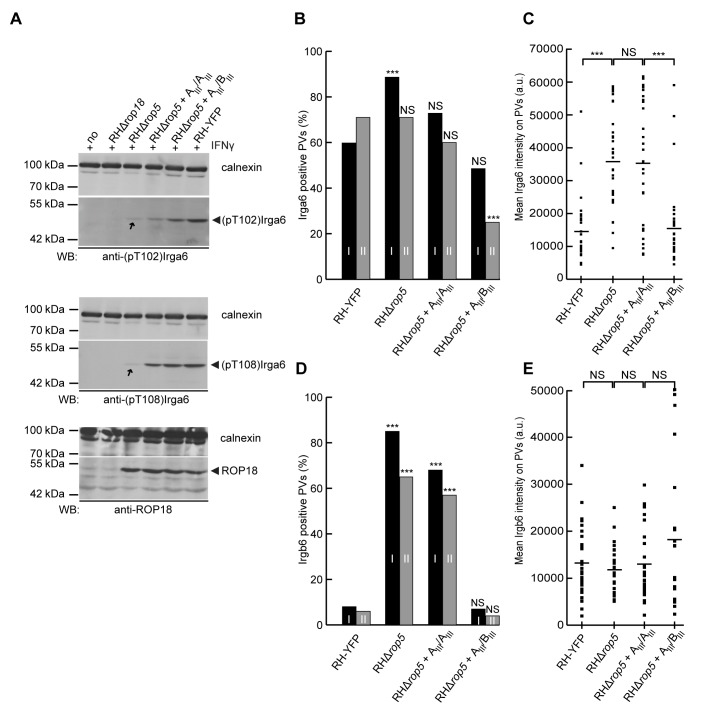
ROP5 isoforms restore virulence-associated functions to RHΔrop5.(A) IFNγ-stimulated L929 cells were left uninfected (no) or infected for 2 h with either of the two deletion strains, RHΔrop18, RHΔrop5, or the RHΔrop5 strain transgenic for ROP5 isoforms RHΔrop5+AIII/AIII, or RHΔrop5+AIII/BIII (see Materials and Methods for further details) or RH-YFP. Lysates were resolved on SDS-PAGE and stained on Western blots with anti-pT102 (upper panel) and anti-pT108 (middle panel) antibodies. Expression of ROP5 isoform AIII in RHΔrop5+AIII/AIII resulted in detectably increased phosphorylation of Irga6 compared with RHΔrop5-infected cells. In cells infected with RHΔrop5+AIII/BIII, phosphorylation of Irga6 was restored almost to wt levels. Arrows on the RHΔrop5 tracks indicate what is probably residual kinase activity of ROP18 on Irga6 in the absence of ROP5 since these signals are absent from cells infected with RHΔrop18 (and unpublished data). Signals of ROP18 serve as infection controls for the ROP18-expressing strains (lower panel). Calnexin serves as a loading control. (B, C, D, E) MEFs were induced with 3 U ml−1 IFNγ for 24 h and infected with wt RH, RHΔrop5, RHΔrop5+AIII/AIII, or RHΔrop5+AIII/BIII for 2 h in two independent experiments (I and II, black and grey bars) and positive vacuoles were identified with mAb 10E7 (anti-Irga6) (B) or 141/1 rabbit antiserum (anti-Irgb6) (D). Fluorescent signal intensities shown for Irga6 (C) and Irgb6 (E) for individual vacuoles were determined for visually identified positive vacuoles from experiment II as described in Materials and Methods. Presentation of the data is as described in the legend to Figure 3. As already seen in Figure 3, ROP5 deletion and restoration had relatively modest effects on the proportion of vacuoles loaded with Irga6 (5B), while the effects on loading of Irgb6 (5D) were striking. Again as seen in Figure 3, loss of ROP5 caused a highly significant increase in the intensity of Irga6 loading relative to which RHΔrop5+AIII/AIII-infection had little effect (5C). However, following infection with RHΔrop5+AIII/BIII the intensity of Irga6 loading was reduced to the levels of wild-type RH. As already seen in Figure 3, loading intensities of the few wild-type RH vacuoles loaded with Irgb6 were the same as for the RHΔrop5 vacuoles, as well as for the RHΔrop5+AIII/AIII and RHΔrop5+AIII/BIII vacuoles. Significances shown in Figure 5B and 5D are all relative to the number of Irga6 or Irgb6 loaded vacuoles of the RH strain. Statistical analysis of numerical data for (B) and (D) is given in Table S4. The significances of differences between the datasets shown in Figure 5C and 5E were estimated by the Mann-Whitney U-test.